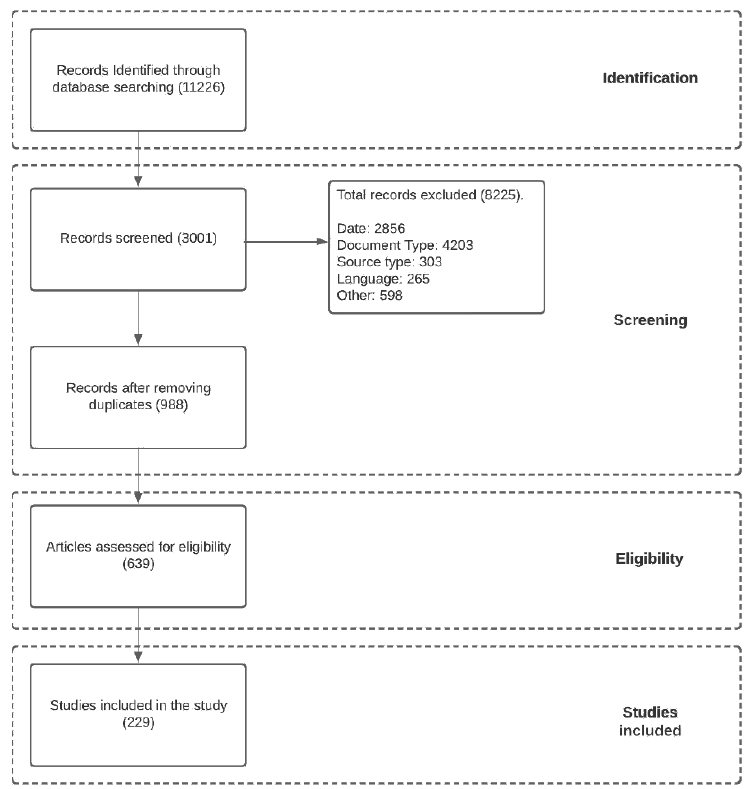
Figure 1. Systematic review methodological flowchart.